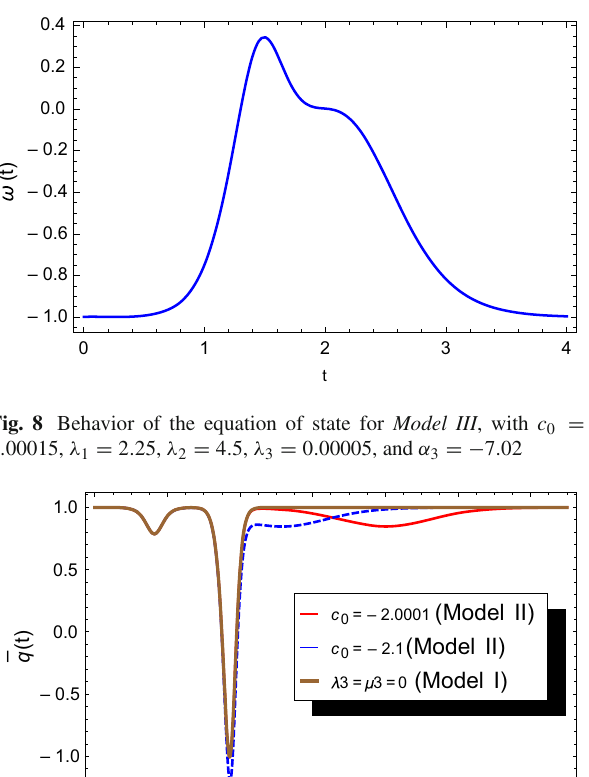
Fig. 5 Hubble factorfor different values of the c 0 parameterwith λ 1 = 2 . 70, λ 2 = 3 . 23, and α 1 = α 2 = − 5 . 9. The (blue) dotted and (red) thin lines stands for λ 3 = μ 3 = 0 . 9